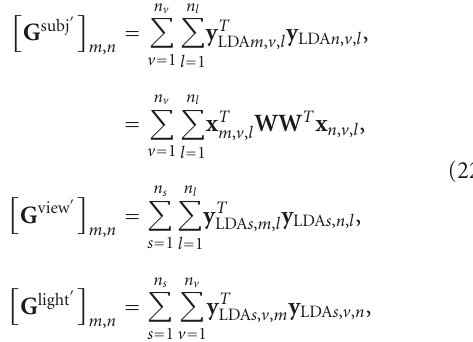
the factor-specific parameters by decomposing Z (cid:2) + y LDA . In Section 3.2, factor-specific parameters obtained by MPCA preserve the three Gram-like matrices G subj , G view , and G light defined in (8). Figure 4 demonstrates that MPCA calculates subject, viewpoint, and lighting parameters using only the colored parts in the Gram matrix. These colored parts represent the dot products between pairs of samples that have only one varying factor. For example, the colored parts in Figure 4(a) represent the dot products of di ff erent subjects’ face images under fixed viewpoint and lighting condition. Based on these observations, among the dot products of pairs of LDA projections, we only use the dot products which correspond to the colored parts of G in Figure 4. Replacing x with y LDA , we define three new